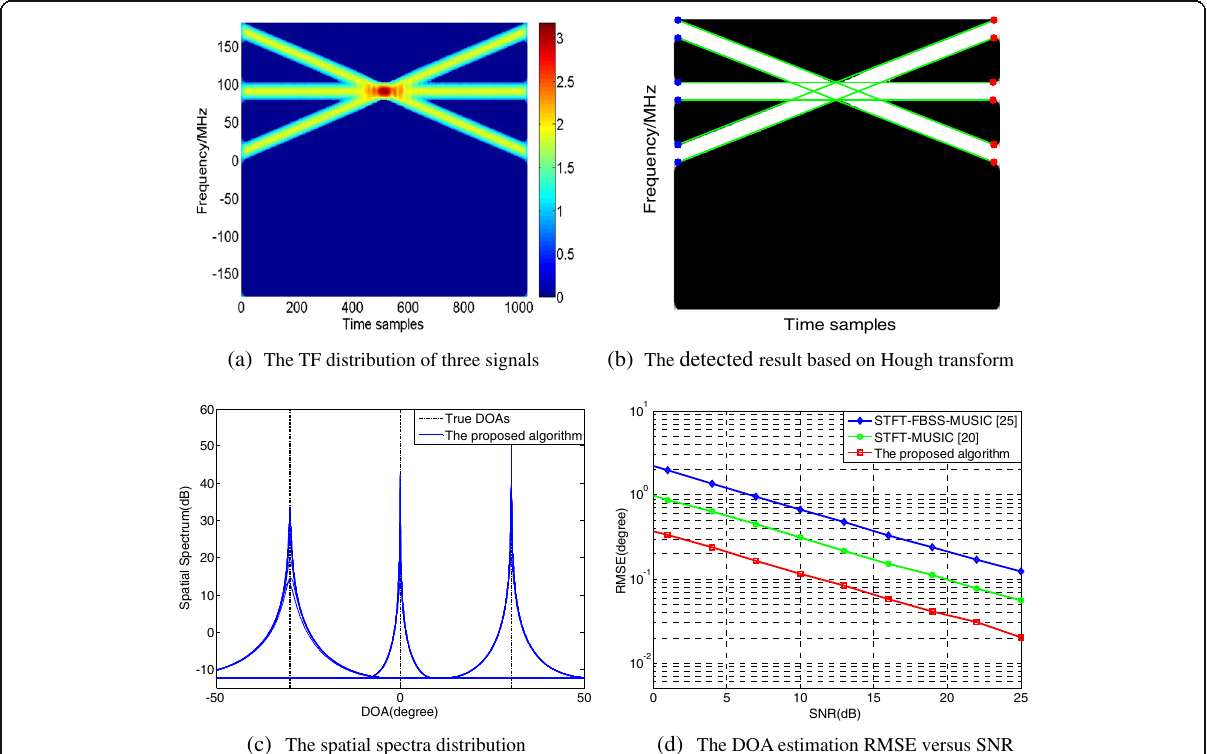
Fig. 7 The DOA estimation results analysis, ( a ) the TF distribution of three signals, ( b ) the detected result based on Hough transform, ( c ) the spatial spectra distribution, ( d ) the RMSE of DOA estimation versus